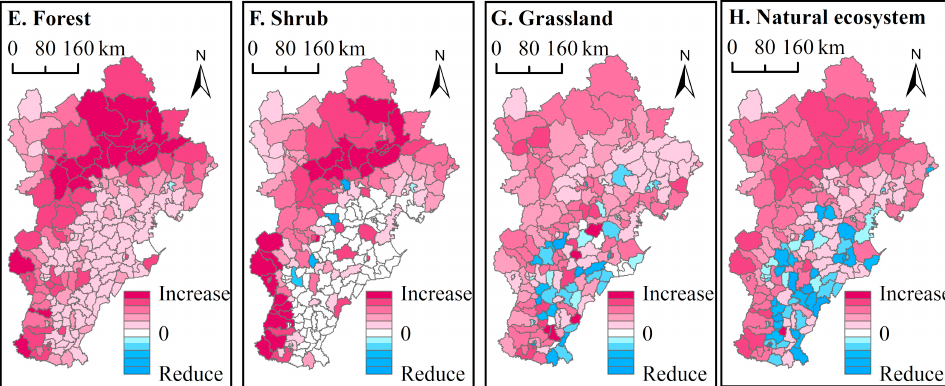
Figure 10. Distribution and changes in the county-level natural ecosystem asset index in the Beijing– Tianjin–Hebei urban agglomeration from 2000 to 2015: ( A ) spatial distribution of forest ecosystem asset index in 2015; ( B ) spatial distribution of shrub ecosystem asset index in 2015; ( C ) spatial distribution of grassland ecosystem asset index in 2015; ( D ) spatial distribution of natural ecosystem asset index in 2015; ( E ) spatial distribution of forest ecosystem asset index change from 2000 to 2015; ( F ) spatial distribution of shrub ecosystem asset index change from 2000 to 2015; ( G ) spatial distribution of grassland ecosystem asset index change from 2000 to 2015; ( H ) spatial distribution of natural ecosystem asset index change from 2000 to 2015.